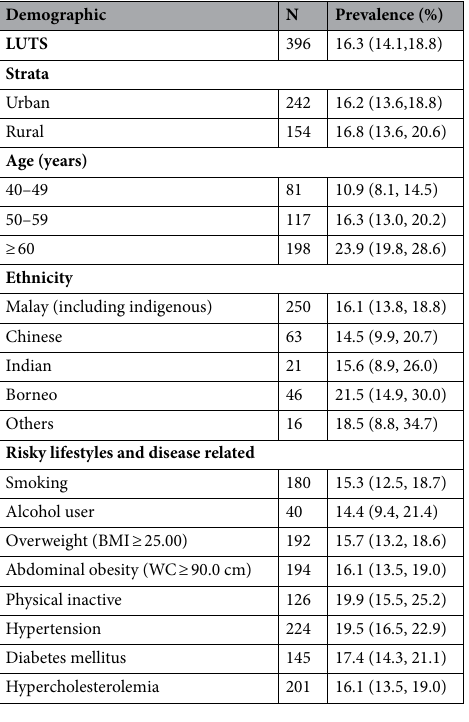
Table 1. Prevalence of LUTS by demographic, risky lifestyles and disease related in